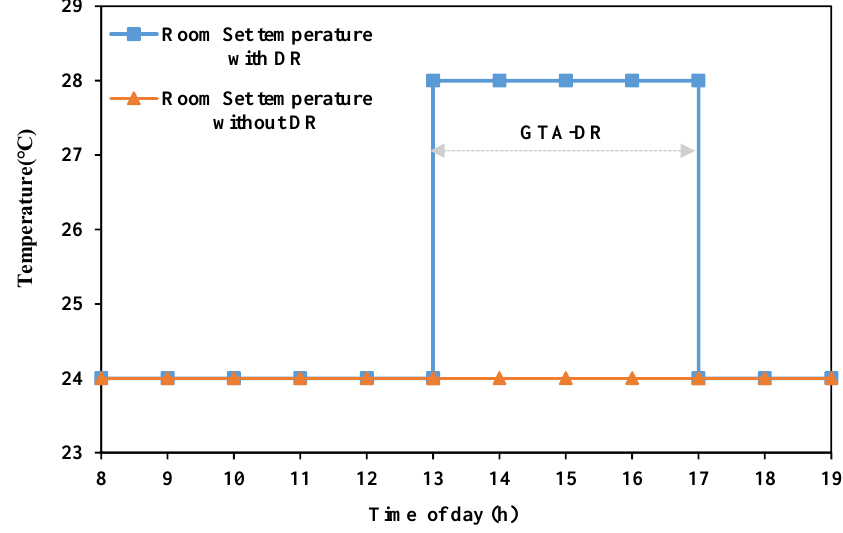
Figure 6. Room temperature settings.